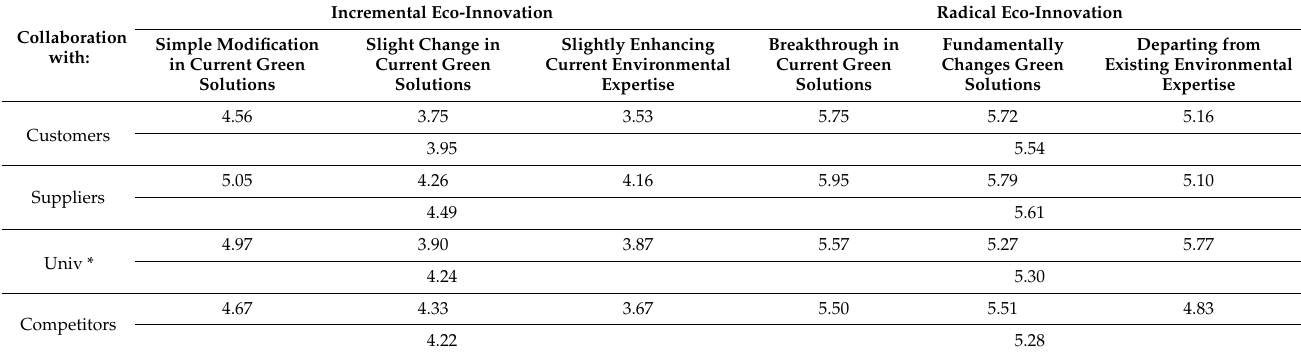
Table 2. Propensity to generate eco-innovation as a result of cooperation with external partners. Collaboration